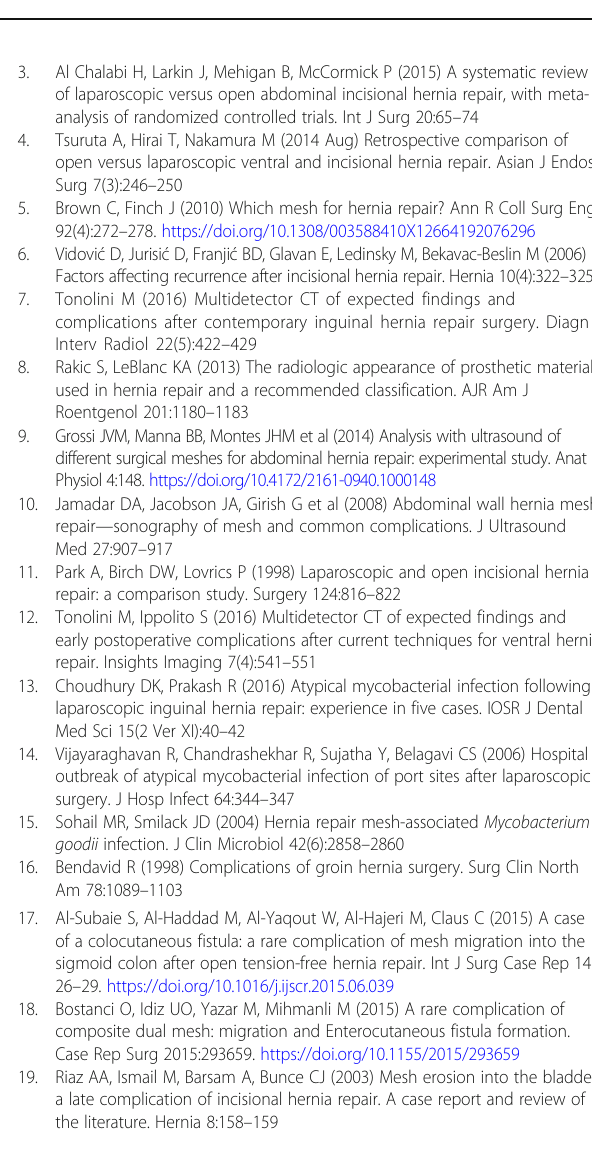
Fig. 16 a Illustration of ilioinguinal and iliohypogastric nerve. EO external oblique, IO internal oblique, TA transverse abdominis, ASIS anterior superior iliac spine. b Axial CT at level of anterior superior iliac spine shows the nerves (arrow) between the transverse abdominis (TA) and internal oblique (IO)